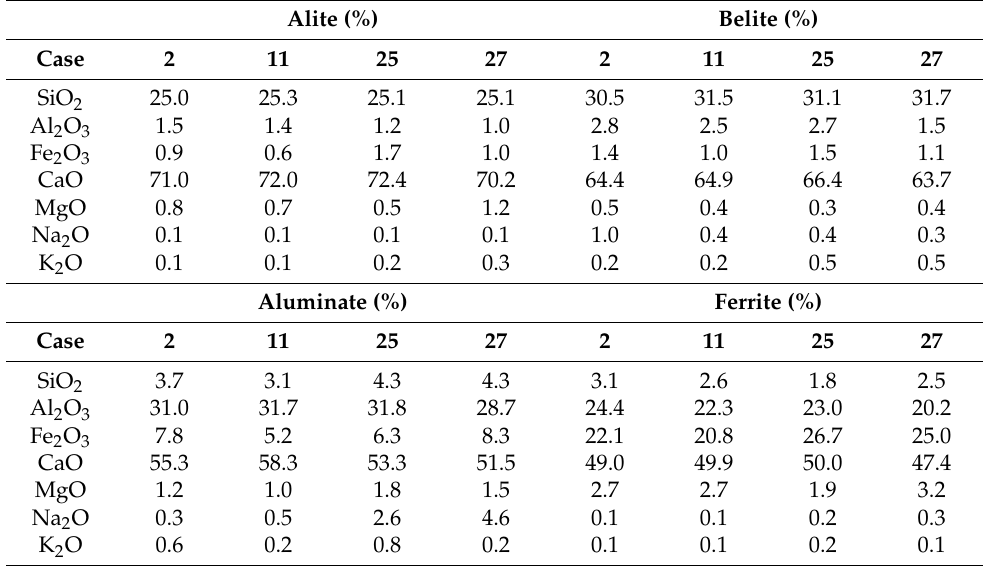
Table 6. Chemical compositions of the cement compounds reported by Kristmann [15].